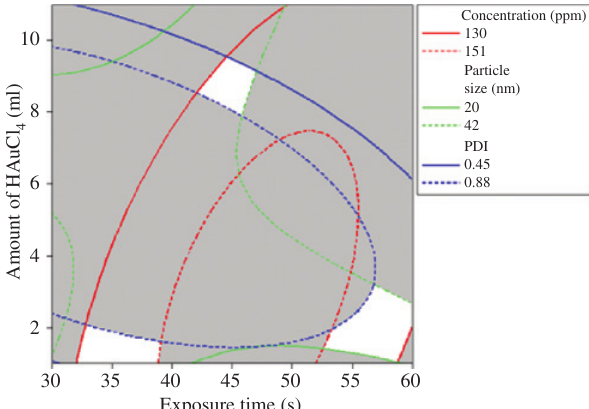
Figure 4: Overlaid contour plot of AuNPs particle size, concentra- tion, PDI with acceptable levels as function of microwave exposure time, and amount of HAuCl solution. 4